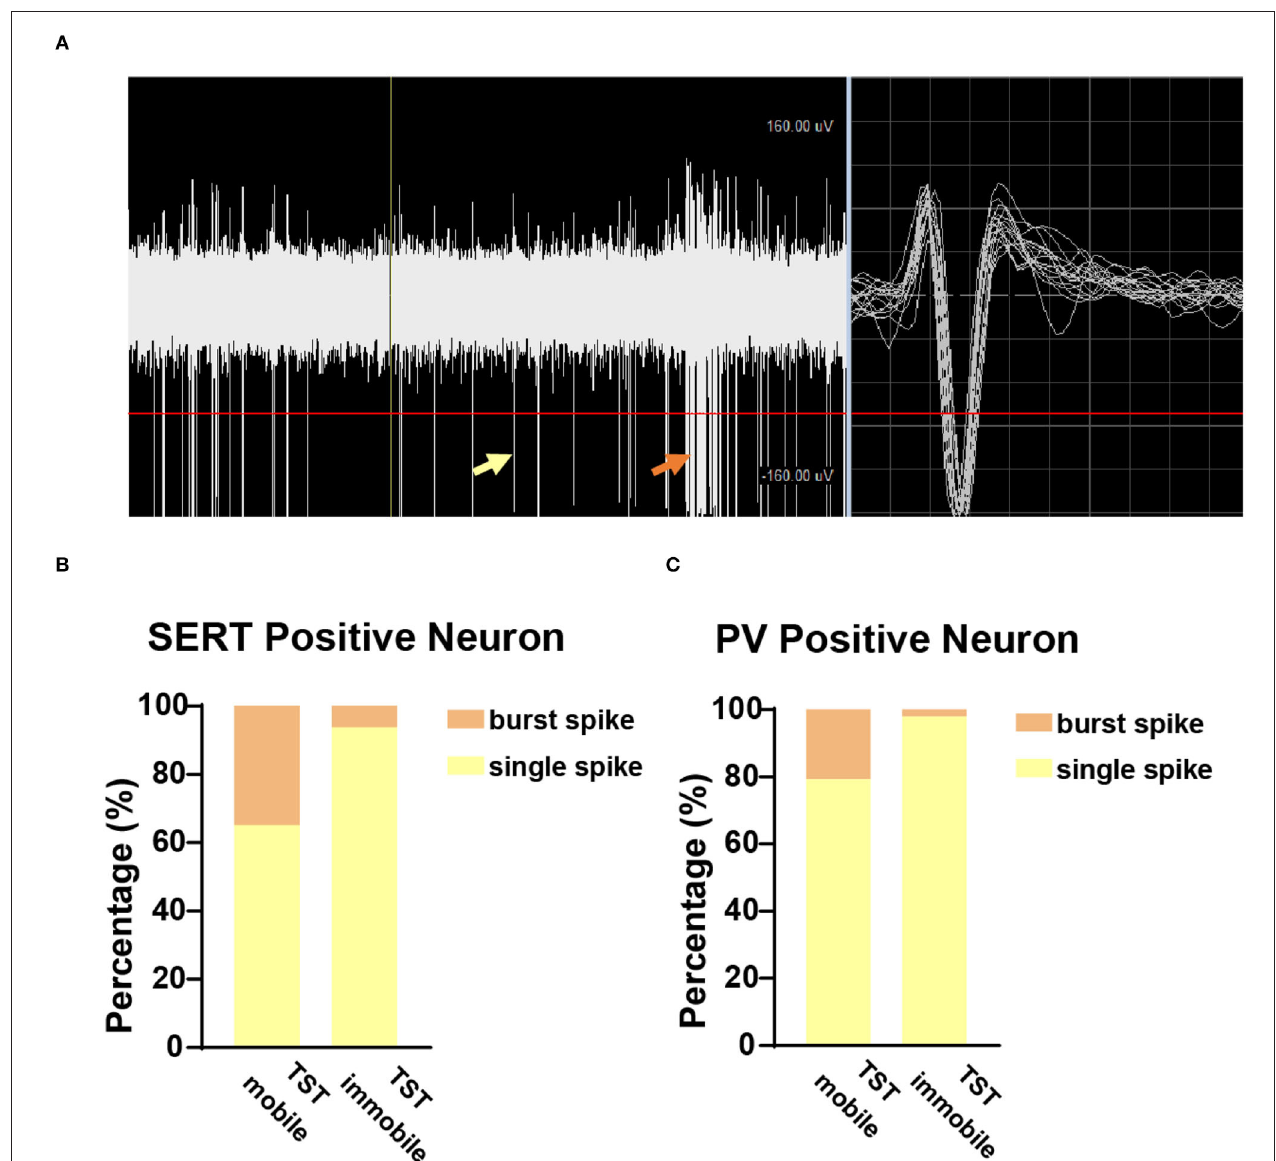
FIGURE 5 | Few burst spikes during the immobile state in TST. (A) Sample picture showed burst spike (orange arrow) and single spike (yellow arrow) while recording. (B) The proportion of burst and single spike in SERT DRN neuron firing during TST mobile and immobile states. (C) The proportion of burst and single spike in PV DRN neuron firing during TST mobile and immobile